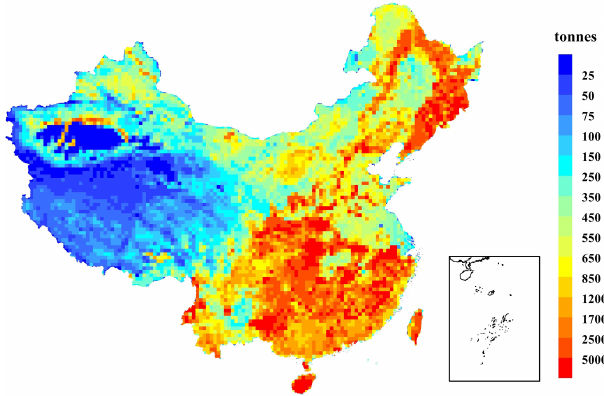
Figure 1. Spatial variations in BVOC emissions in June